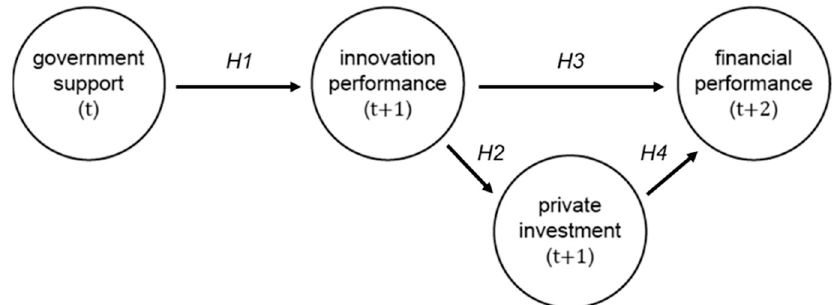
Figure 1. Research framework.